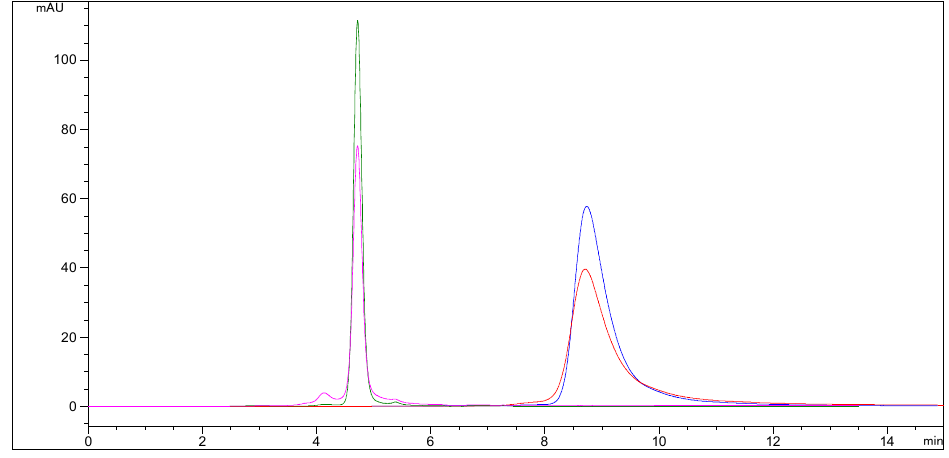
Figure A8. Representative chromatograms of Lf control sample and alkaline stress sample for two SEC columns: −− control sample and −− alkaline stress sample (Separation was performed on a BioSep™-SEC-S 2000 column at 25 ◦ C using 0.05 M sodium phosphate buffer containing 0.5 M NaCl (pH 7.0) as a mobile phase at a flow rate of 0.8 mL/min), −− control sample and −− alkaline stress sample (Separation was performed on an XBridge ® Protein BEH SEC 200 Å column at 25 ◦ C using a 0.2 M sodium phosphate buffer containing 0.1 M NaCl (pH 6.8) as a mobile phase at a flow rate of 0.86 mL/min).